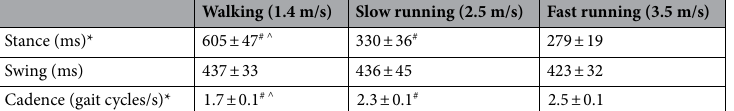
Table 1. Duration of the stance and swing phases and cadence during walking and running (average value ± standard deviation). *Statistically significant gait effect (p < 0.05). # Statistically significant differences (post hoc analysis) to fast running (p < 0.05). ^ Statistically significant differences (post hoc analysis) to slow running (p < 0.05).